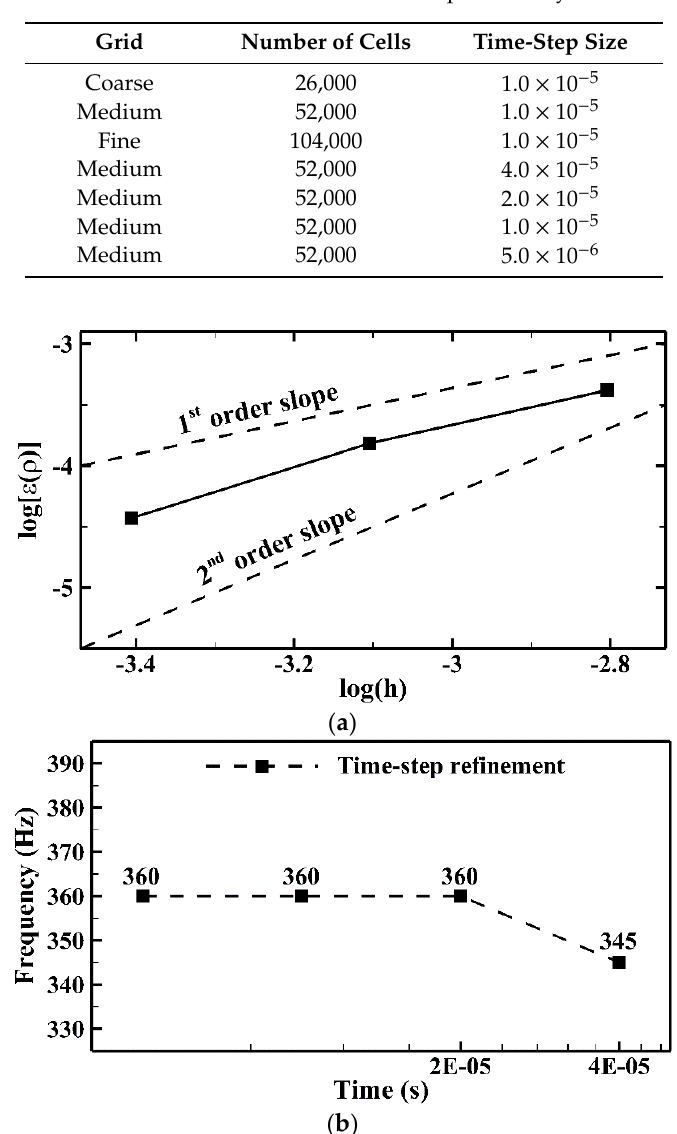
Figure 3. Grid refinement and time-step sensitivity results: ( a ) Grid convergence; ( b ) time-step